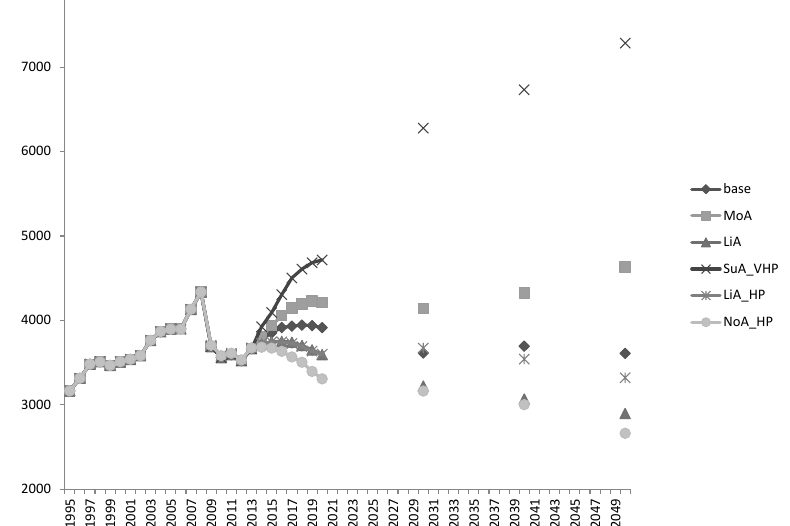
Fig. 5. Cereals production (1000 tons). Base = Baseline; MoA = Moderate adaptation (yields +10%); LiA = Little adaptation (yields –10%); SuA_VHP = Successful adaptation, very high prices (yields +30%, crop prices+30%); LiA_HP = Little Adaptation, high prices (yields –10%, crop prices +10%); NoA_HP = No adaptation, high prices (yields –20%, crop prices